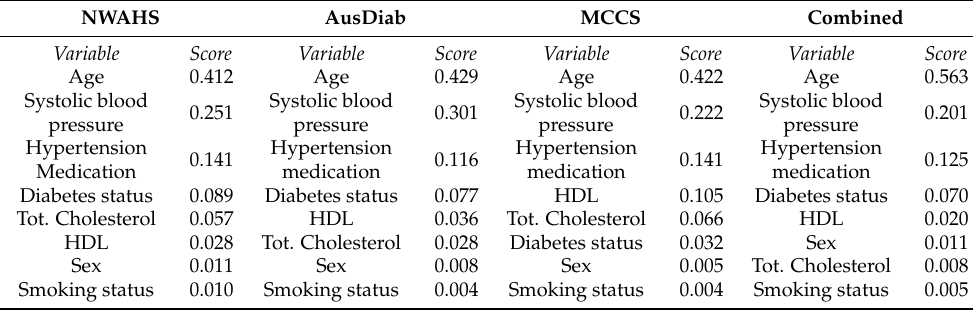
Table 5. Variable ranking based on their contribution to the prediction for NWAHS, AusDiab, and MCCS populations. Variables are listed based on their contribution (Score) to the predictions.